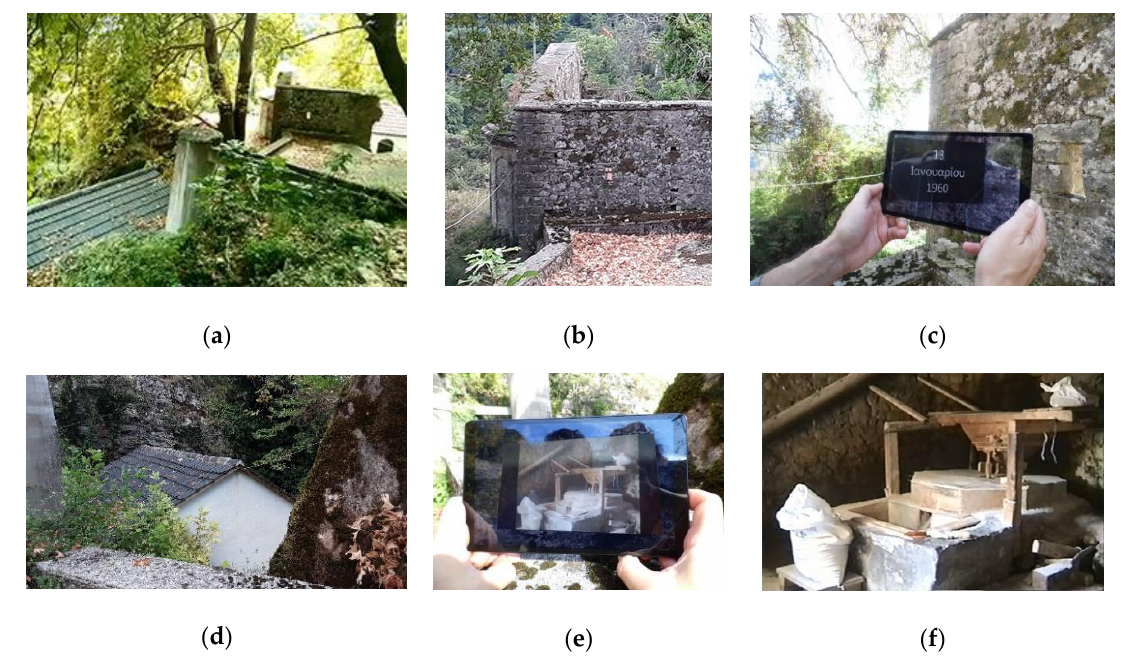
Figure 1. The hybrid reality environment. ( a ) The physical environment; ( b ) The ruins of the old church; ( c ) The old church’s building triggers the AR app and reveals its history; ( d ) Outside the watermill; ( e ) The watermill triggers the AR app and reveals its history; ( f ) Inside the watermill in the operational days of the previous decades.